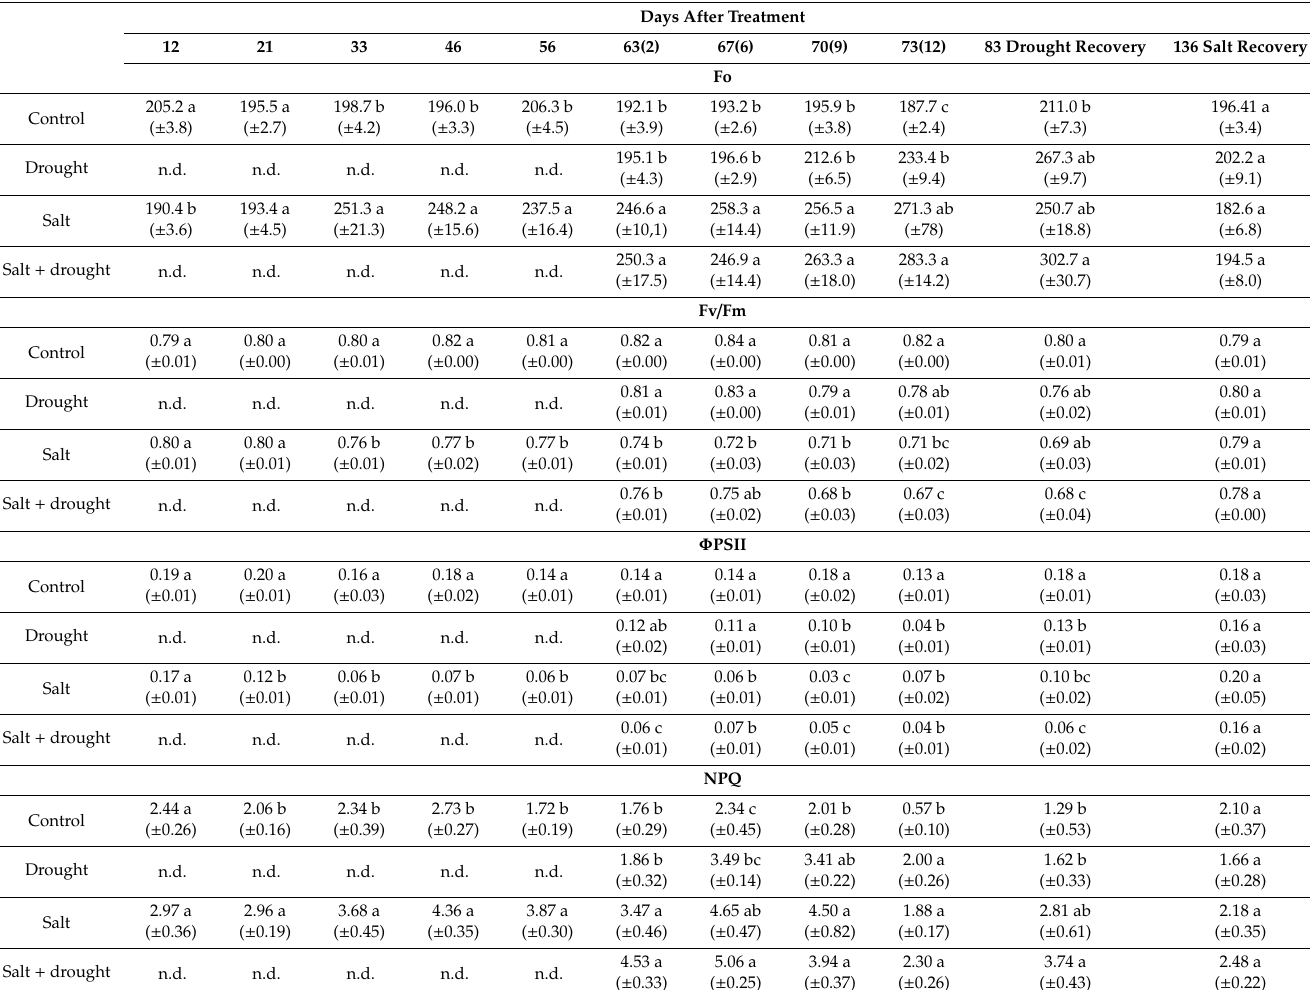
Table 2. Mean values ( ± SE) chlorophyll a fluorescence parameters for sweetgum plants a ff ected by the factors of drought, salt, and their combination on each day after treatment. Data (in column) followed by the same letter do not di ff er significantly ( p < 0.05), n.d. = not